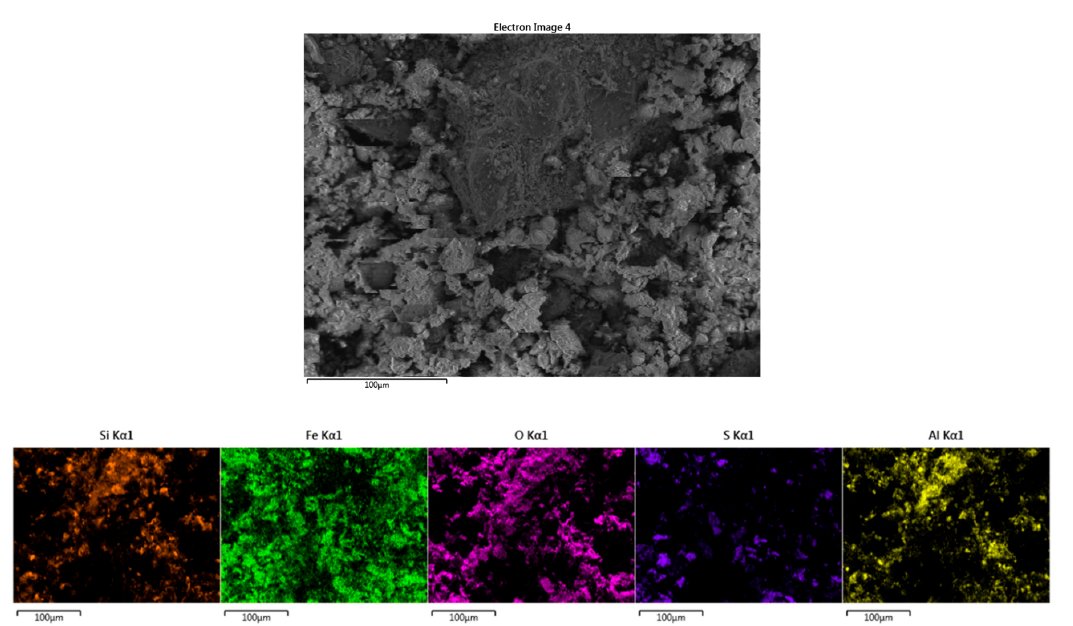
Figure 8. EDS images of magnetically separated roasted raw tailings.